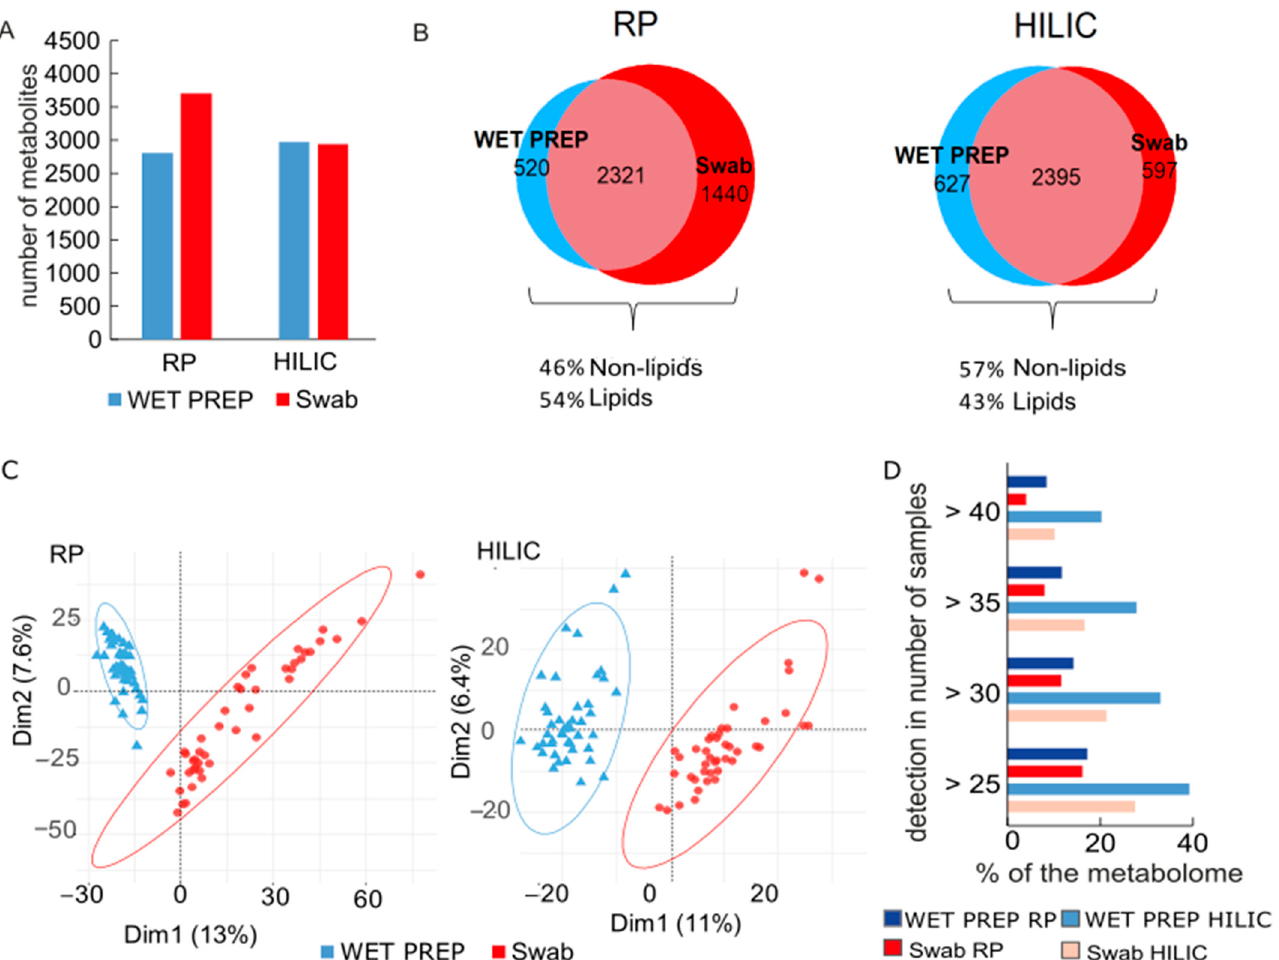
Figure 1. Metabolome overview of skin samples according to sampling method, WET PREP (light blue) and swab (red) for HILIC and RP columns : Total number of annotated metabolites ( A ); Venn diagrams of the total number of compounds according to sampling method with percentage of lipids-compounds had to be present in at least 2 samples per sampling method to be considered ( B ); PCA score plot ( C ); Percentage of shared metabolome across samples with HILIC (lighter colors) and RP (darker colors) ( D ).